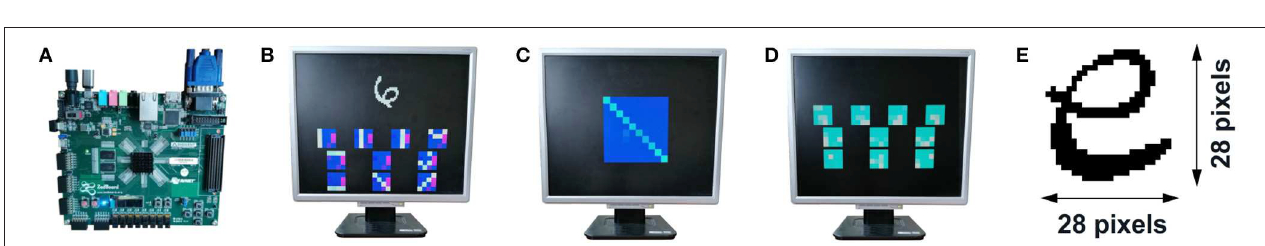
FIGURE 5 | Digital STDP learning activities of three equalized patterns for the non-trained class “5” (A) . The evolution of pattern and background average conductances depends on the appearance rate R P . Note that R P affects the opening of the average synaptic window between pattern and background, as evident by the corresponding synaptic images: the more a pattern appears at the input, the wider the window (B) . Note that the three learning activities are stable and do not present any errors. This efficiency has been achieved thanks to spike frequency adaptation, which optimizes the specialization of each post-neuron.